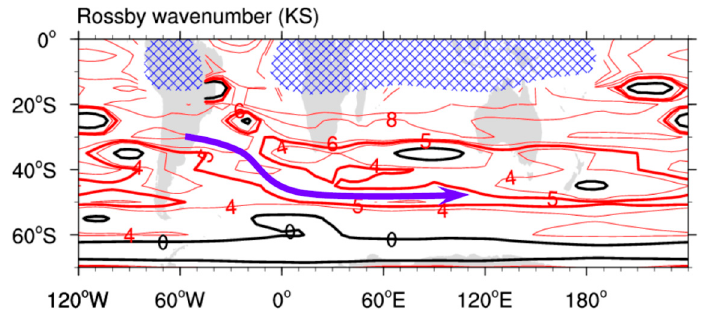
Figure 6. Total wavenumber of stationary Rossby wave (KS) at the 200 Pa in austral summer. Contours are drawn at 0, 4, 5, 6, 8, 10, 15, and 20. The contour for wavenumber 0 (where the Rossby wave is refracted) is drawn in black, and the rest are in red. The hatched areas depict the regions of climatological easterly averaged over 1980–2016, and the arrow for the Southern Hemisphere westerly jet waveguide with the maximal KS larger than 5 by the thick red